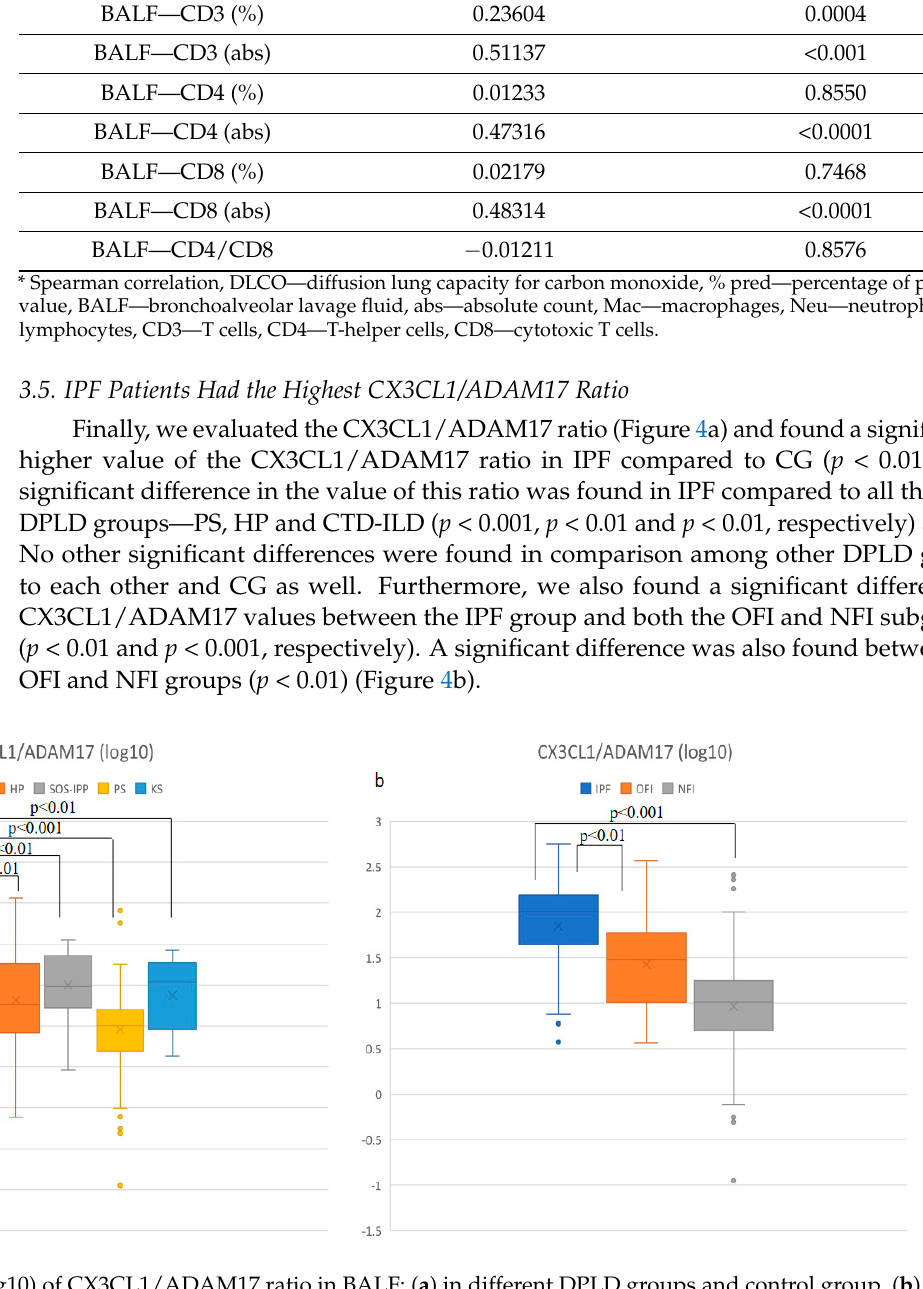
Figure 4. Comparison (log10) of CX3CL1/ADAM17 ratio in BALF: ( a ) in different DPLD groups and control group, ( b ) in idiopathic pulmonary fibrosis (IPF), other fibrosis than IPF group (OFI) and non-fibrosis group (NFI). Idiopathic pulmonary fibrosis (IPF)—median: 105.5, interquartile range (IQR): 72.3; hypersensitivity pneumonitis (HP)—median: 18.2, IQR: 50.0; connective tissue disease-associated interstitial lung disease (CTD-ILD)—median: 26.4, IQR: 42.5; pulmonary sarcoidosis (PS)—median: 10.1, IQR: 10.8; control group (CG) median: 34.6, IQR: 50.4; OFI—median: 30.0, IQR: 72.6; NFI—median: 10.2, IQR: 12.7.